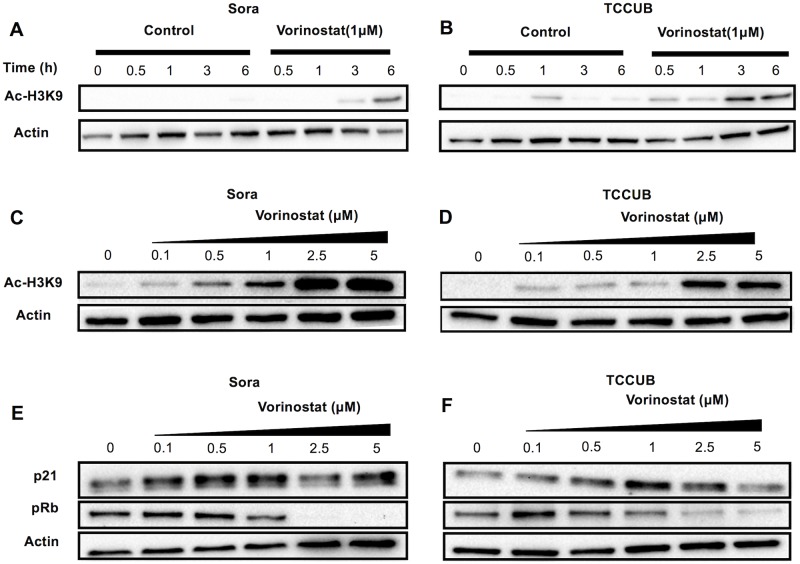
Representative results of western blot analysis of H3 acetylation (A-D) and cell cycle-related molecules, p21 and p-Rb (E, F).Cells were incubated with 1 μM vorinostat for 0.5–6 h (A, B), with 0.1–5 μM vorinostat for 24 h (C, D), and with 1 μM vorinostat for 24 h (E,F). Whole cell lysates were analyzed by western blot analysis.